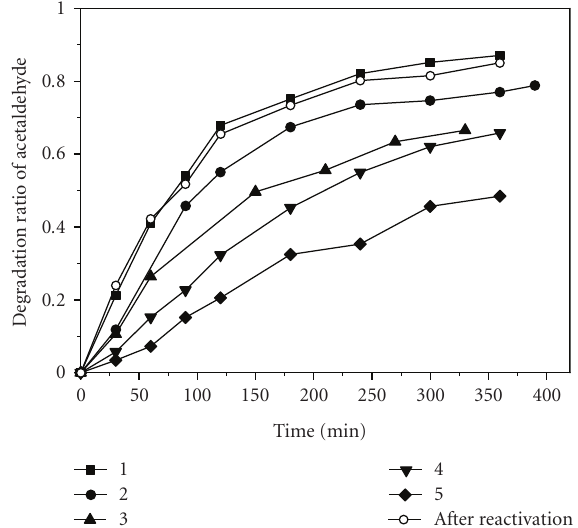
Figure 9: Gaseous acetaldehyde degradation rates on T2 for five consecutive runs and regenerated T2 (heating at 300 ◦ C for 1 hour) under UV-light irradiation ( λ =